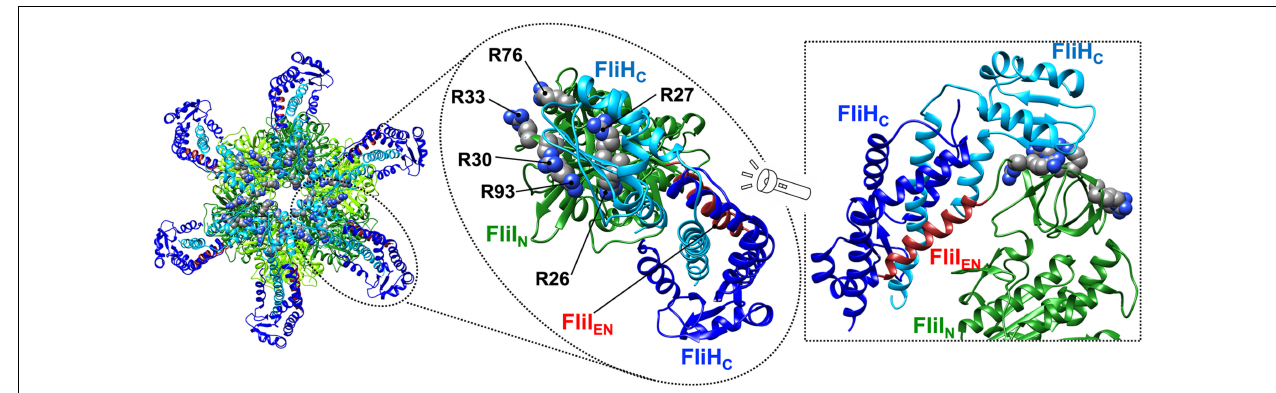
FIGURE 6 | Atomic model of the FliH C12 -FliI 6 ring complex. C α ribbon representation of the FliH C2 -FliI 1 complex (PDB ID: 5B0O) is shown. The C-terminal domain of FliH (residues 141–235, FliH C ) forms a dimer via an interaction of residues 101–140, which adopt a coiled-coil structure. The FliH C dimer binds to each N-terminal domain (FliI N ) of the FliI 6 ring. Interestingly, one FliH C domain (blue) binds to the N-terminal α -helix consisting of residues 2–21 of FliI (brown, FliI EN ), and the other (cyan) binds to a positively charged region formed by R26, R27, R30, R33, R76, and R93 of FliI. These two domains adopt conformations that are completely different from each